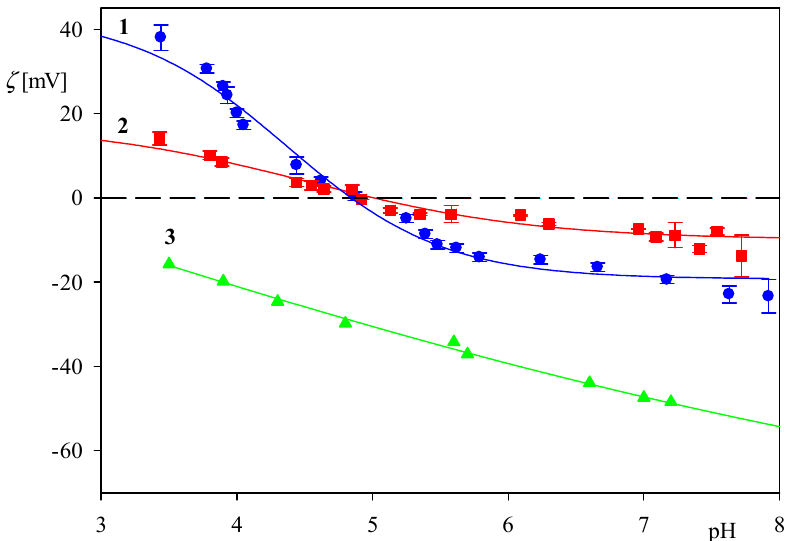
Figure 1. Dependence of the zeta potential on pH for: 1. myoglobin molecules in 0.01 M, NaCl (LDV measurements), 2. myoglobin molecules in 0.15 M, NaCl (LDV measurements), 3. silica in 0.01 M, NaCl (the streaming-potential measurements).